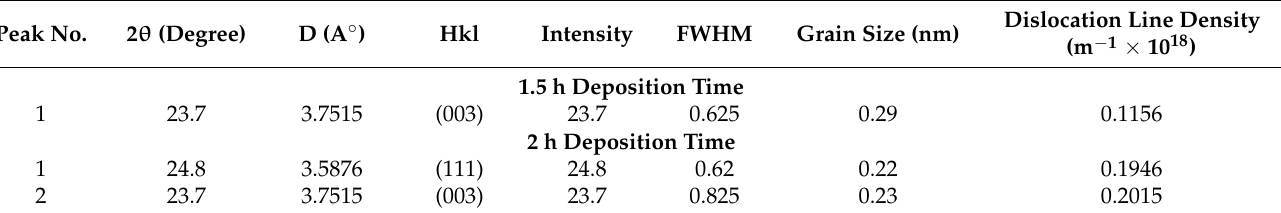
Figure 2. XRD patterns of 10% Mg-Doped AlSb thin films for 1–3 h. Table 2. The XRD data of 10% Mg-doped AlSb deposited thin films at 1.5 and 2 h.